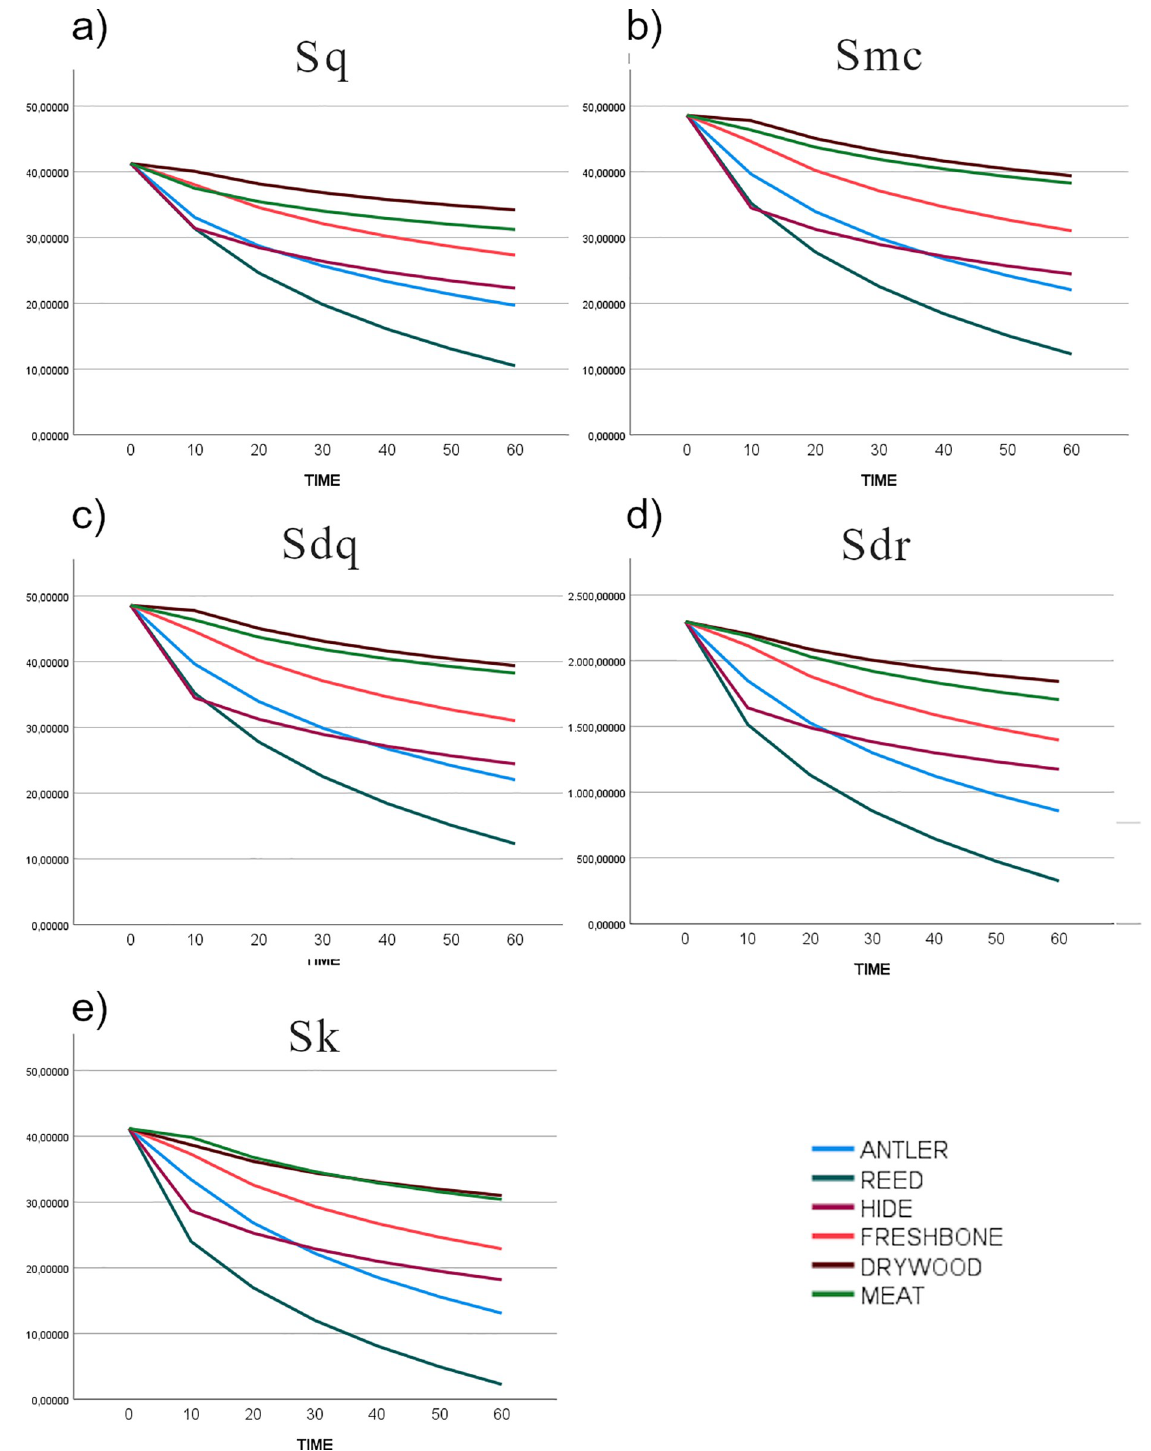
Fig 6. Evolution of five texture parameters Sq (a) Smc (b) Sdq (c) Sdr (d), Sk (e) through time (0, 10, 20, 30, 40, 50, 60 minutes). Predicted values fitting a logarithmic regression.